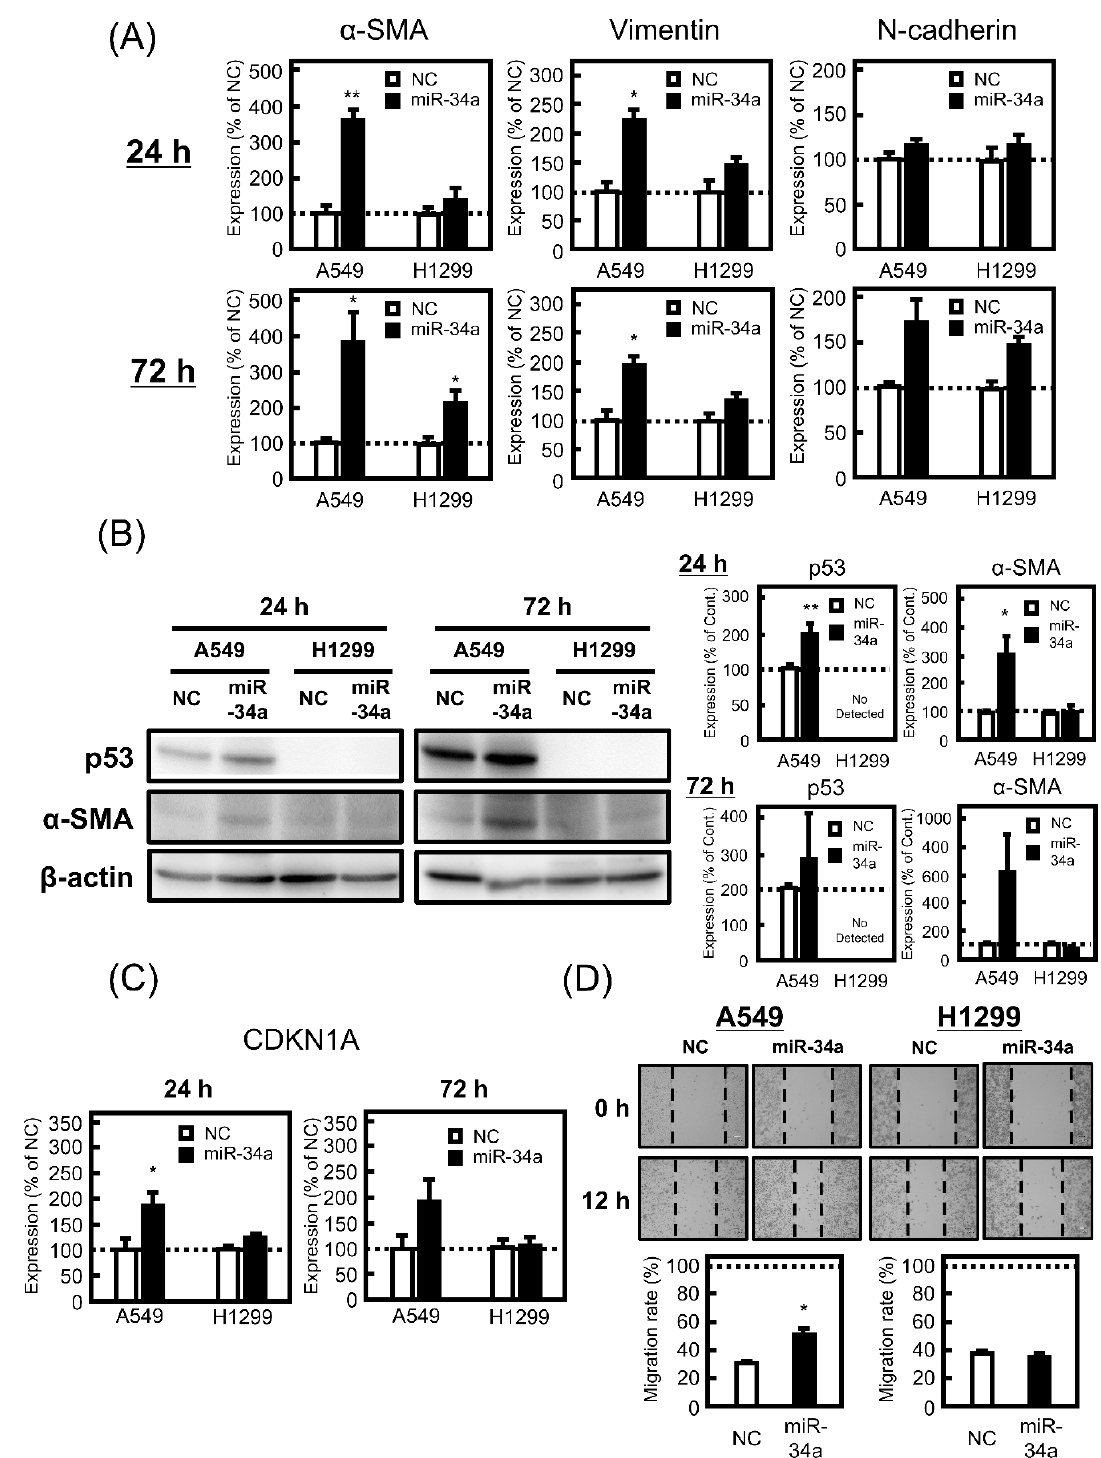
Figure 2. Effect of miR-34a overexpression on epithelial–mesenchymal transition (EMT)-related phenotypes in A549 and H1299 cells. These cells were transfected with NC (20 pmol/well) or miR-34a mimic (20 pmol/well) for 24 h. After 24 or 72 h, the mRNA expression levels of ( A ) α-smooth muscle actin (α-SMA), vimentin, N-cadherin, and ( C ) cyclin-dependent kinase inhibitor 1A (CDKN1A) were measured by real-time PCR. ( B ) Protein levels of α-SMA and p53 were analyzed by Western blotting. ( D ) The migration ability was confirmed by scratch-wound assay as described in Section 2. Each value represents the mean ± S.E.M. (n = 3). * p < 0.05, ** p < 0.01, significantly different from NC.